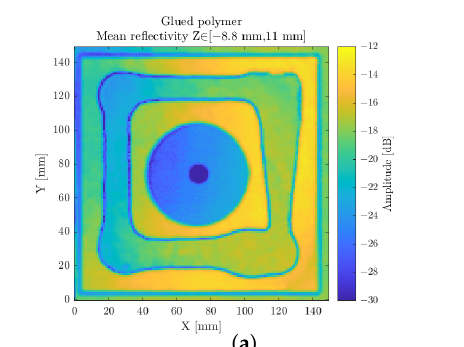
Figure 13. The glued polymer scan, considered on a longitudinal range of interest ( a ). Photography of the front and back sides of the sample ( b ).